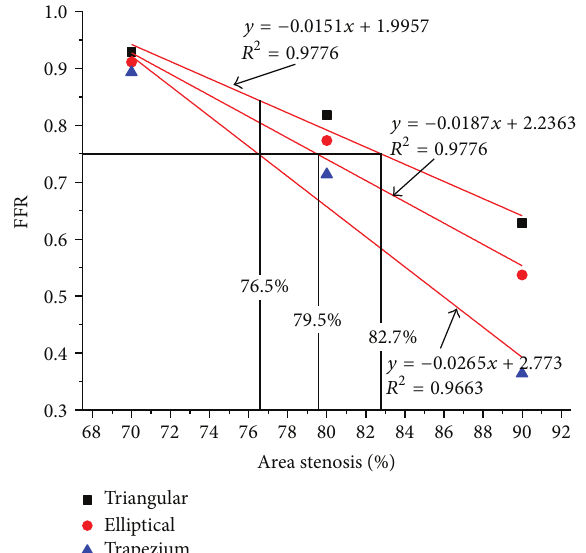
Figure 5: Variation of FFR values with different shapes of stenosis (triangular, elliptical, and trapezium).